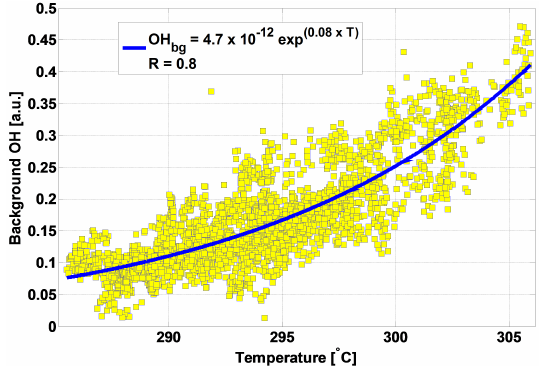
Figure 5. Background OH as a function of the temperature during the HUMPPA-COPEC 2010 campaign.